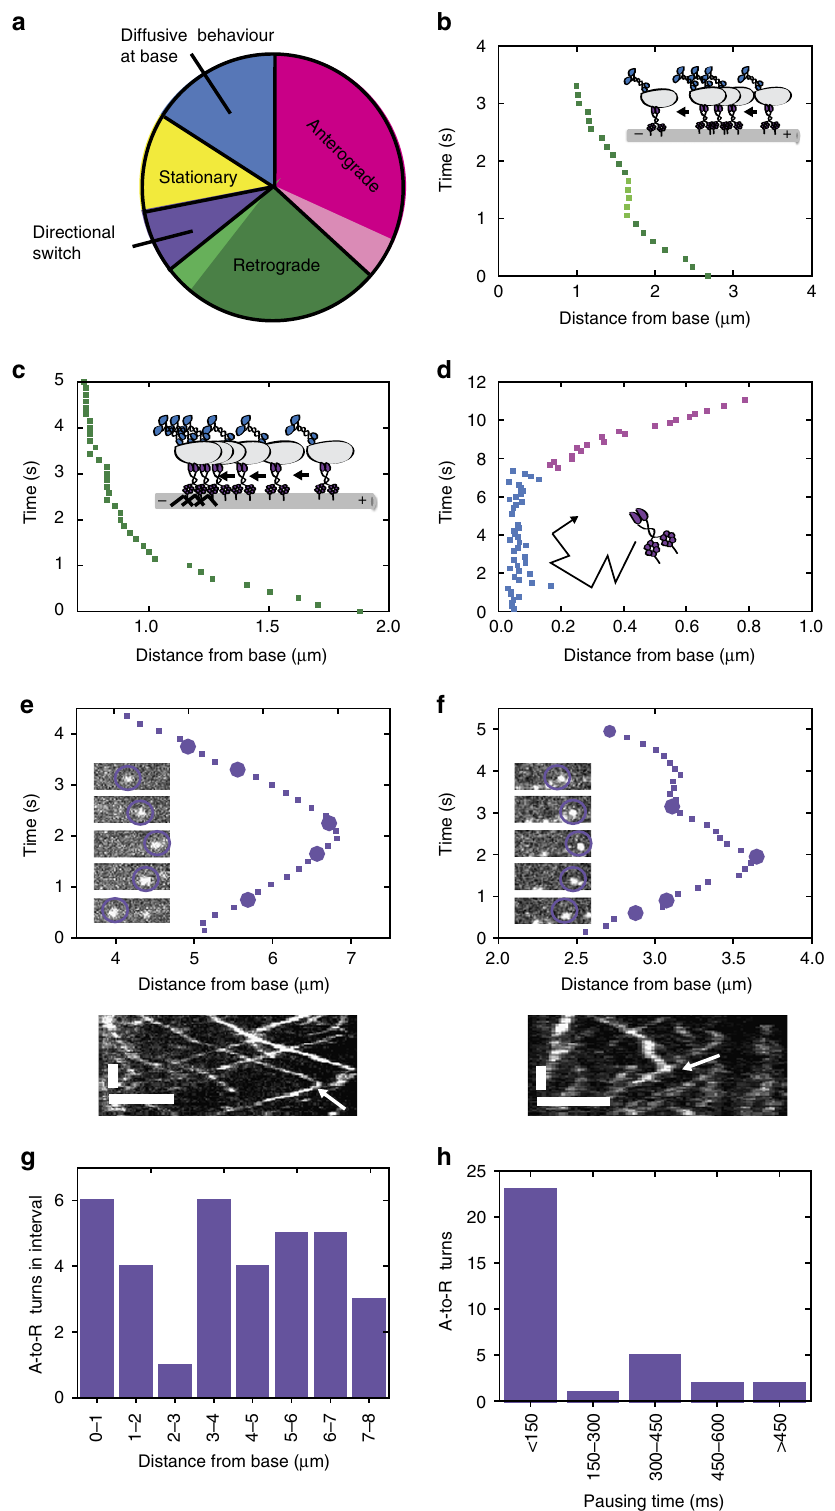
Figure 3 | Single-molecule quantification reveals novel IFT-dynein behaviour. ( a ) Quantification of single-motor IFT-dynein trajectories: 37% anterograde motion (magenta), of which 14% with pausing (light magenta); 27% retrograde motion (green), of which 13% with pausing (light green); 16% at the base (blue); 12% stationary (yellow); 8% turnarounds (purple); n ¼ 494 trajectories from 7 worms. Only trajectories of 600ms or longer are taken into account. ( b – f ) Representative single-motor IFT-dynein traces showing: pausing (light green) in unidirectional trajectories ( b ), deceleration upon reaching the ciliary base ( c ), diffusive behaviour at the ciliary base ( d ) and A-to-R (anterograde to retrograde) directional switches at different positions with corresponding images and kymograph ( e , f ). ( e , f ) Time: vertical; scale bar, 2s. Position: horizontal; scale bar, 2 m m. Arrow indicates turnaround position. The movie corresponding to ( f ) is shown in Supplementary Movie 2. ( g , h ) Histograms of IFT-dynein A-to-R turnarounds ( n ¼ 34) showing their location and pausing time. R-to-A not shown (only four recorded